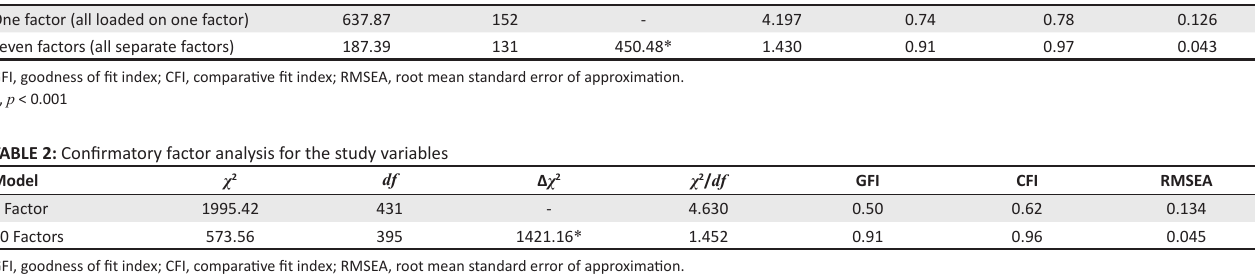
TABLE 1: Confirmatory factor analysis for the human resources management practices factors. Factor models